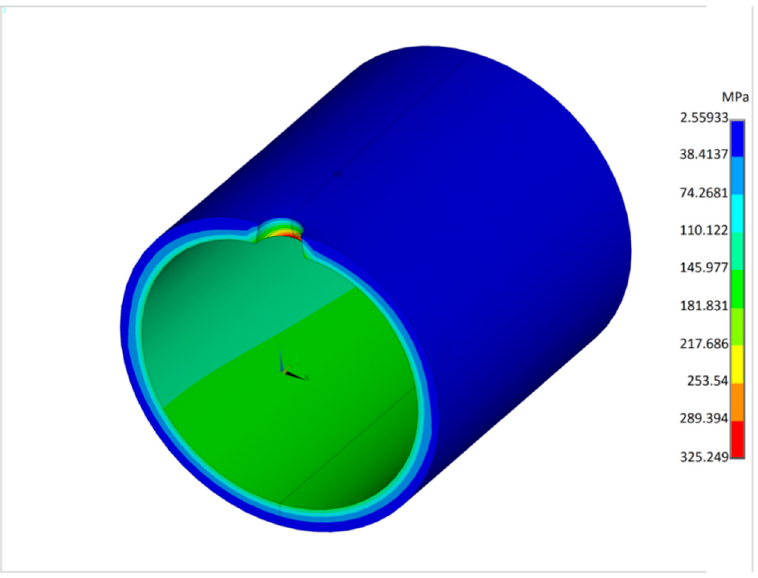
Figure 18. Distribution of equivalent von Mises stress in time 688 s.